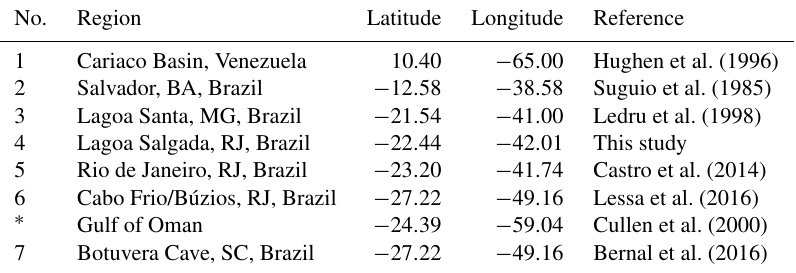
Table 1. Locations of published records cited. No. Region Latitude Longitude Reference 1 Cariaco Basin, Venezuela 10.40 − 65 . 00 Hughen et al. (1996) 2 Salvador, BA, Brazil − 12 . 58 − 38 . 58 Suguio et al. (1985) 3 Lagoa Santa, MG, Brazil − 21 . 54 − 41 .